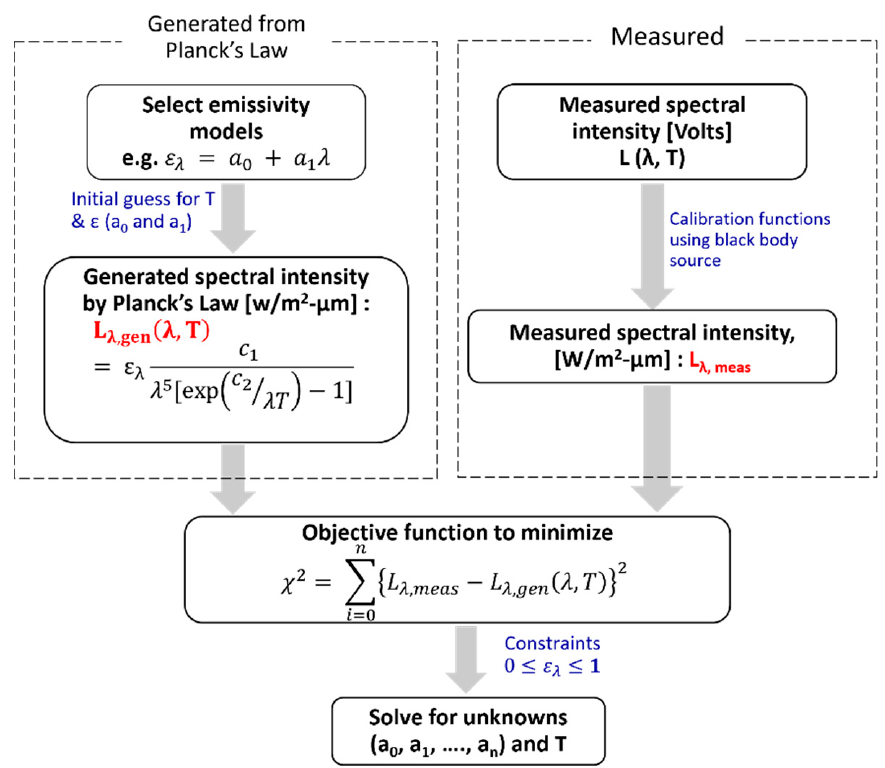
Figure 6. Solution optimization schematic for NLLS MRT.